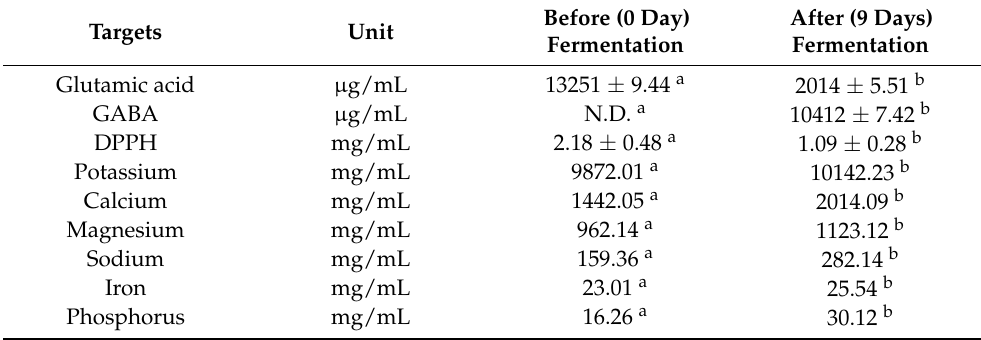
Figure 3. Fermentation effects on GABA production pattern in FAME. Thin-layer chromatogram (TLC) for MSG standard (0.25–1%), GABA standard (0.25–1%), and 5-fold dilution of FAME samples collected at different time intervals (0, 1, 3, 5, 7, and 9 days) during fermentation. Table 2. GABA production and changes in DPPH and other components of aronia extract fermented by L. plantarum